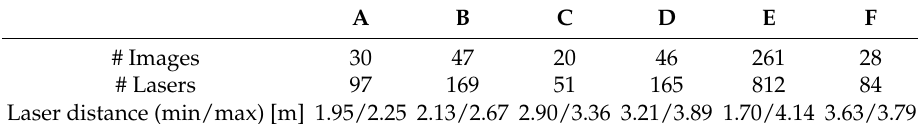
Table 5. Distribution of laser observations per segment for AUTT28